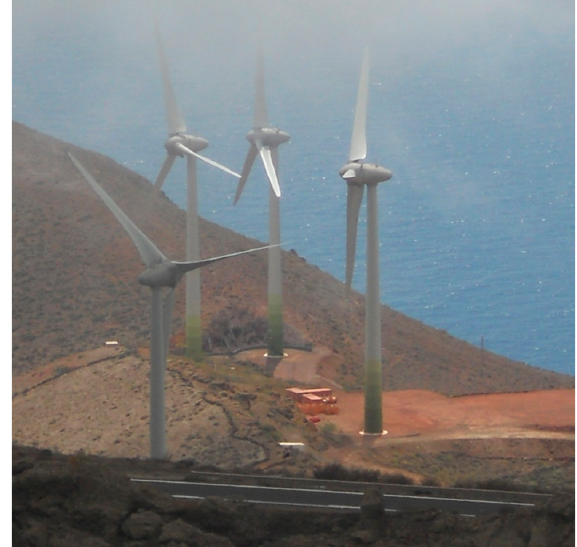
Figure 8. Wind power plant in the El Hierro hybrid power system where four of the five turbines are shown. Photo: G. Jastrz ę bska.